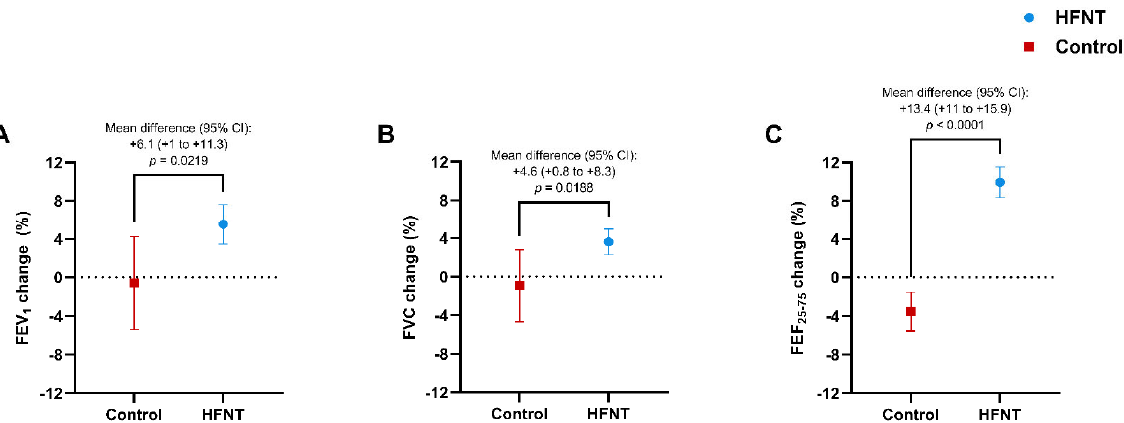
Figure 4. Changes in FEV 1 % ( A ), FVC% ( B ), and FEF 25–75 % ( C ) in HFNT and control group at baseline and after 12 months. Data are expressed as mean (95% CI). Abbreviations: HFNT, high-flow nasal therapy; FEV 1 , forced expiratory volume in the first second; FVC, forced vital capacity; FEF 25–75 , forced expiratory flow between 25% and 75% of FVC; CI, confidence intervals.